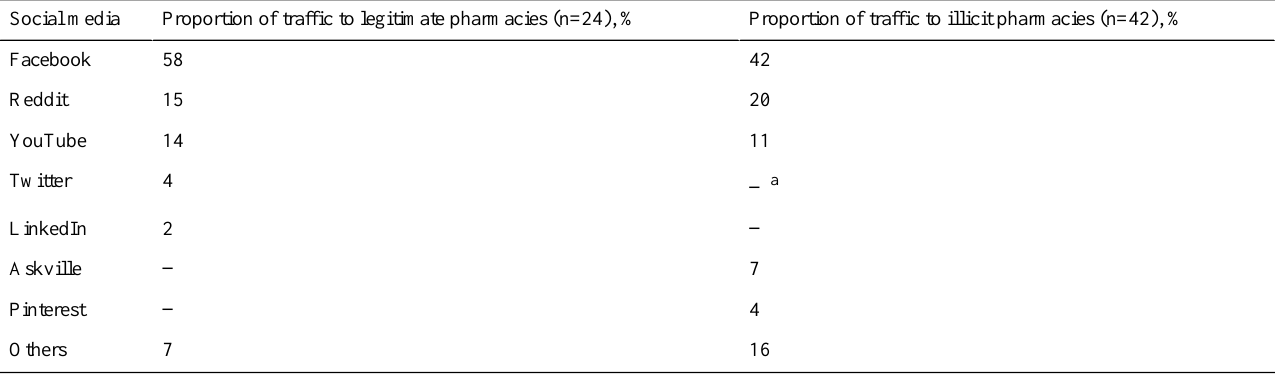
Table 4. Traffic from social media websites to online pharmacies.